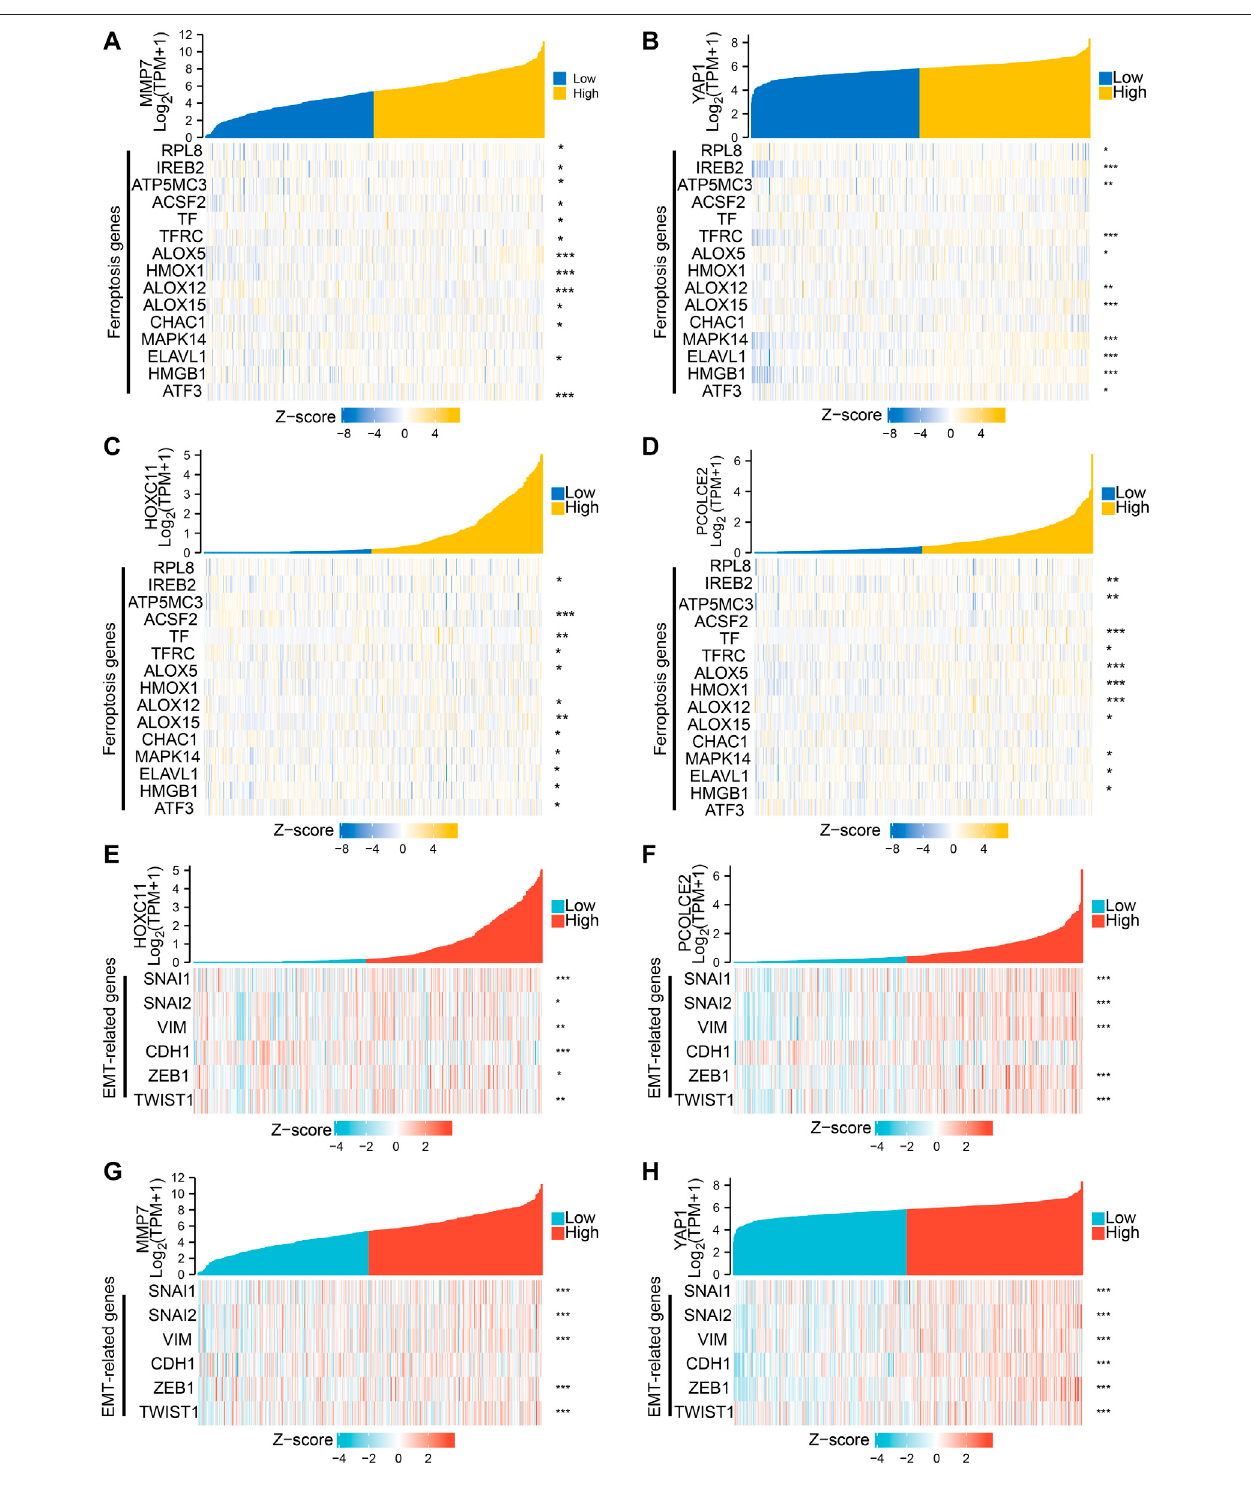
FIGURE 4 | Screening of genes associated with both ferroptosis and invasive migration. The correlation between MMP7 (A) , YAP1 (B) , HOXC11 (C) , PCOLCE2 (D) , and ferroptosis genes was conducted and presented with Single gene co-expression heat map; The correlation between HOXC11 (E) ,PCOLCE2 (F) ,MMP7 (G) , YAP1 (H) and EMT-related genes was performed and shown with Single gene co-expression heat map.